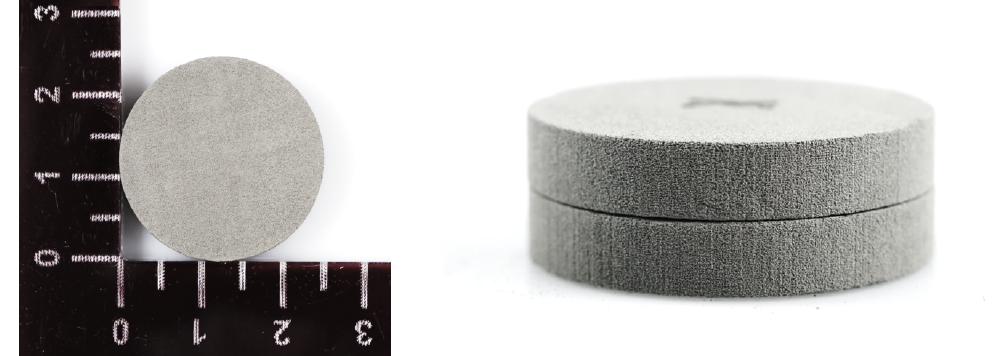
Figure 4. Size of the selected flat cylinder to determine the contact area after sintering ( left ) and stacked green parts before sintering ( right ) (scale in